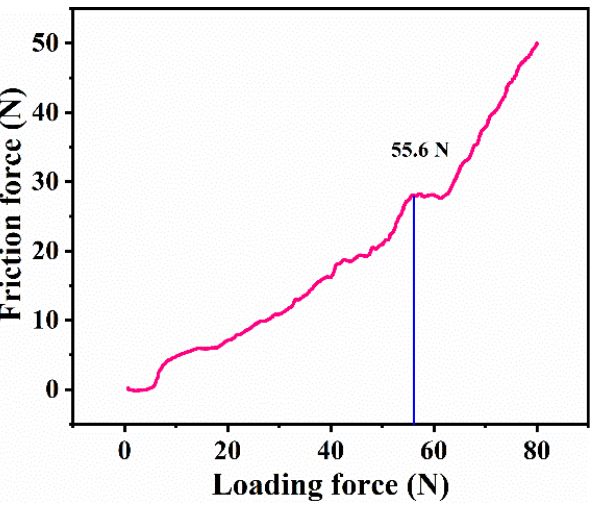
Figure 9. The adhesion test of the optimized electroless Ni–P coating of Mg–Li alloy.